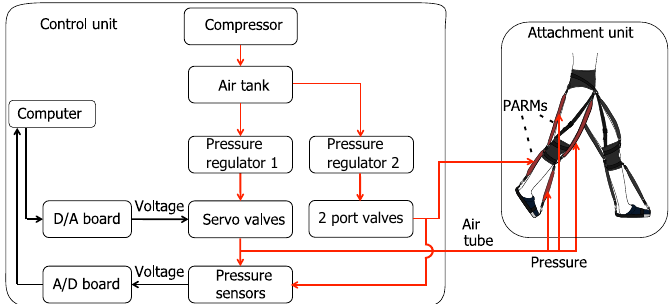
Figure 3. Schematic of the pneumatic control system. The control unit is connected to the attachment unit by the air tube. The pressure in the PARMs is measured by the pressure sensors, and the analog-to-digital (A/D) board sends the pressure information to the computer. Command voltages for the servo valves are calculated by the computer, and are send by the digital-to-analog (D/A) board. The pressure information of the calf back (CB) PARMs is used for an assist timing detection. Air flows into or out from the CB PARMs are closed by the 2 port valves, and these PARMs are used as deformable closed chambers.